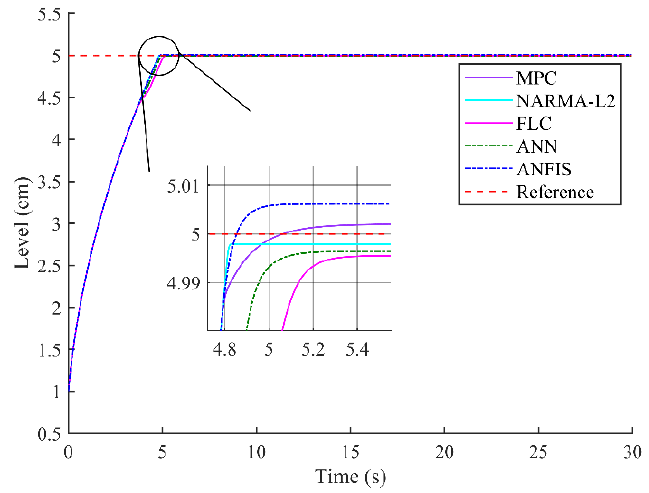
Figure 14. Result of liquid level control in the spherical tank compared to the fixed reference value.